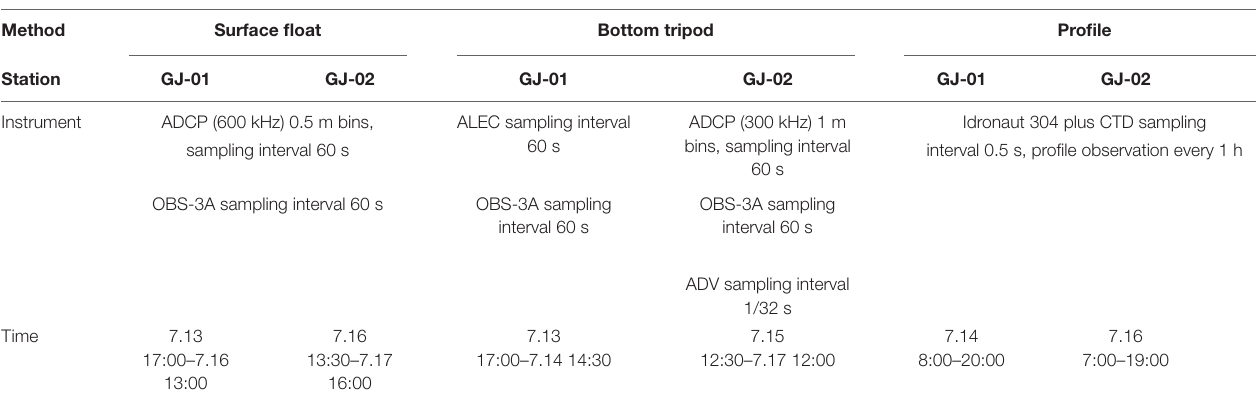
FIGURE 2 | Distribution of longline and cage aquaculture farms in the Sansha Bay based on the Google map digitization (A) , a sketch of a single raft cage, and also a conceptual sketch of tidal boundary layer velocity profiles with (upper panel) and without (lower panel) the influence of suspended cages (B) , and the distribution of cages around GJ-01 and GJ-02 in the Google map photographed on September 12, 2019. An aquaculture unit around GJ-01 is shown on the right, which consists of 22 × 20 cages (C) . The rotated coordinate system is also shown to better represent the real flow direction. The long red line indicates the direction of streamwise component u, whereas the short red line indicates the direction of spanwise component v. TABLE 1 | Information of the instruments and their deployment and working